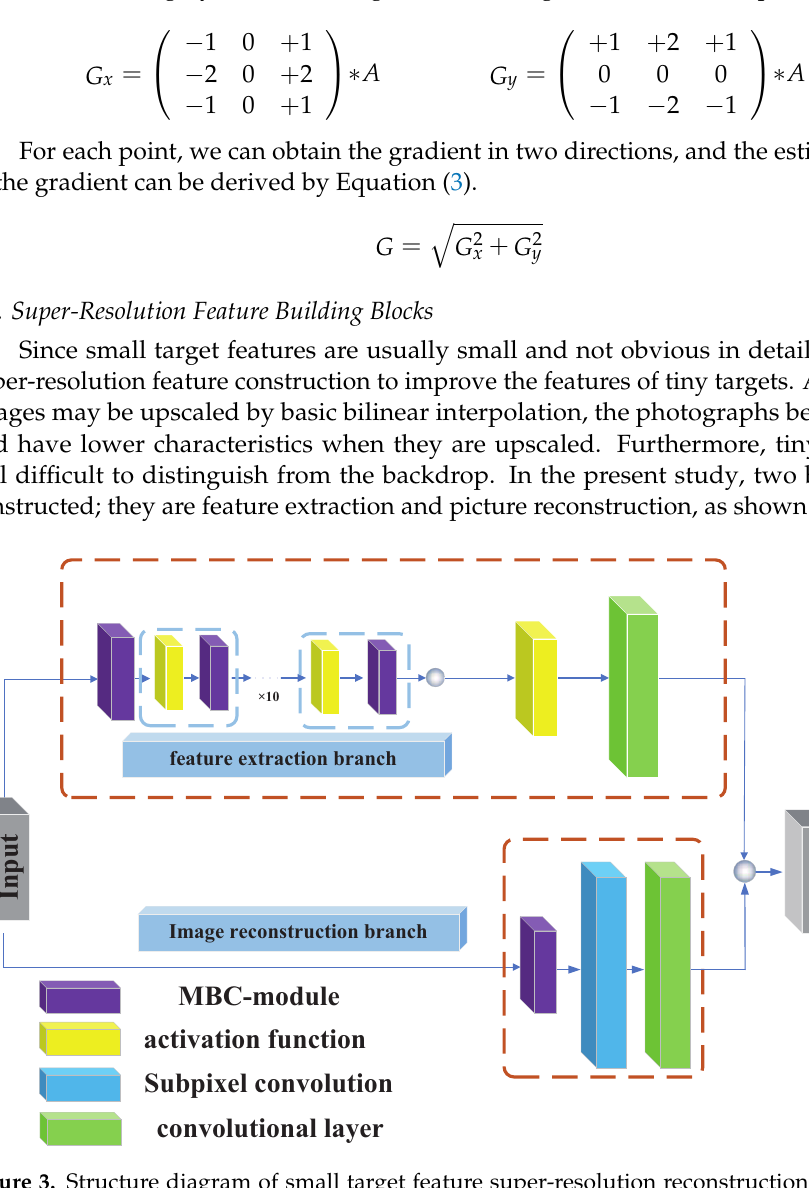
Figure 3. Structure diagram of small target feature super-resolution reconstruction. The module consists of two parts including a feature extraction branch and a feature reconstruction